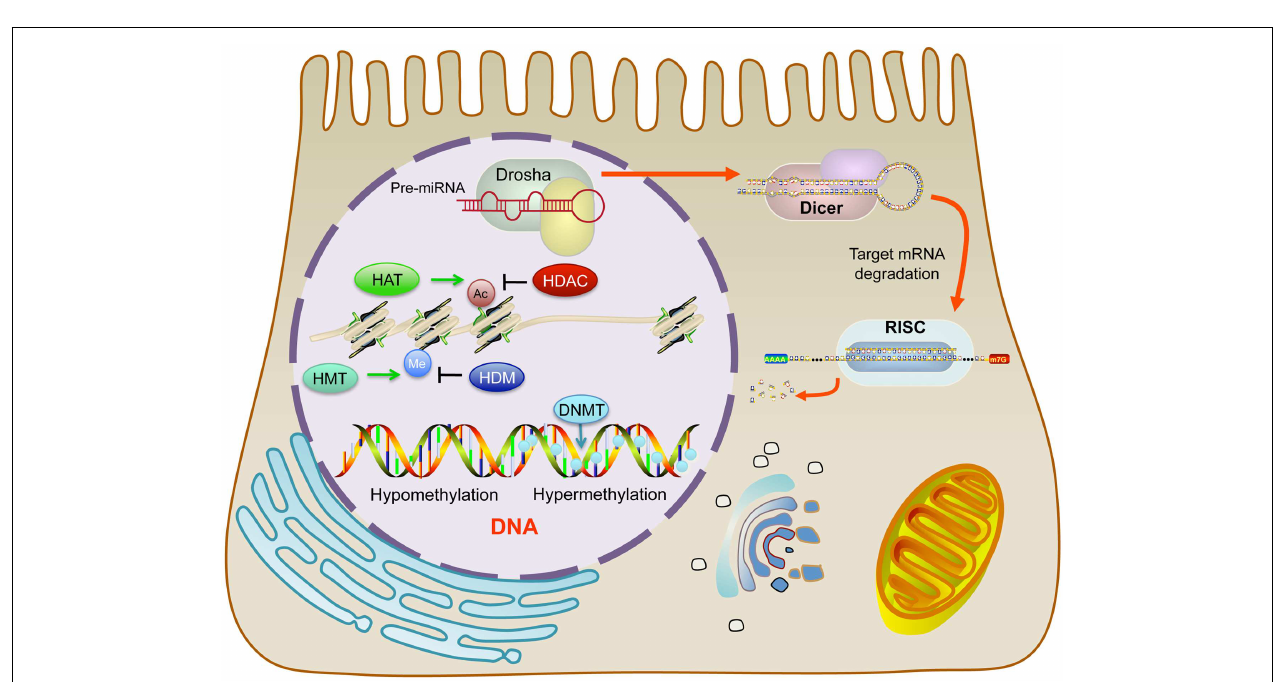
FIGURE 2 | Location of molecular epigenetic mechanisms dynamically affecting gene expression